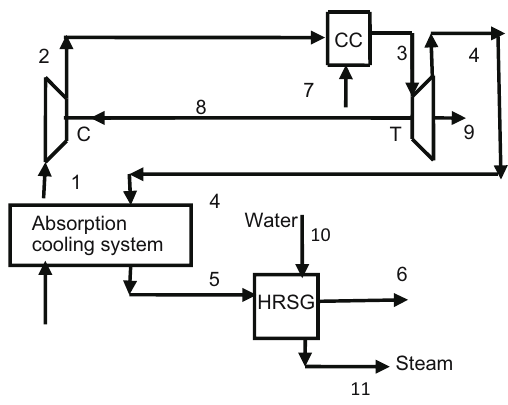
Figure 4: General diagram of the cogeneration system with absorption cooling ( ab )